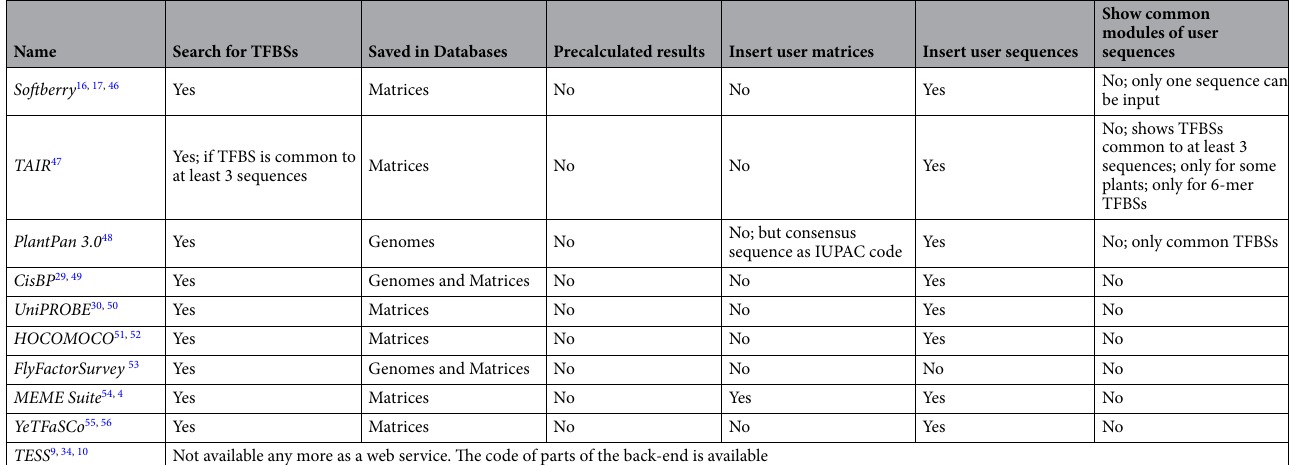
Table 4. Comparison of promoter analysis tools: Further